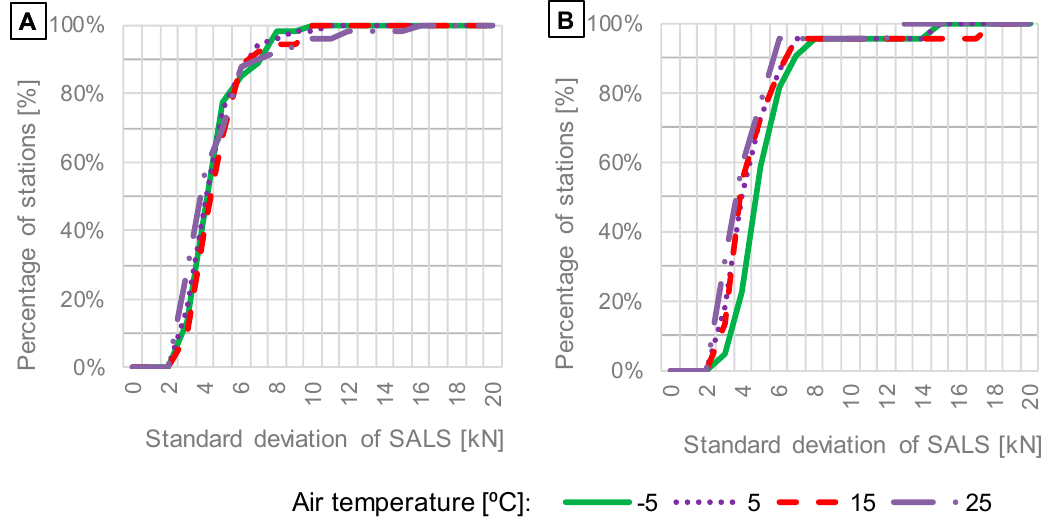
Figure 8. Distributions of standard deviations of SALS in relation to air temperature based on data from WIM systems equipped with: ( A ) quartz piezoelectric; ( B ) bending beam axle load sensors.